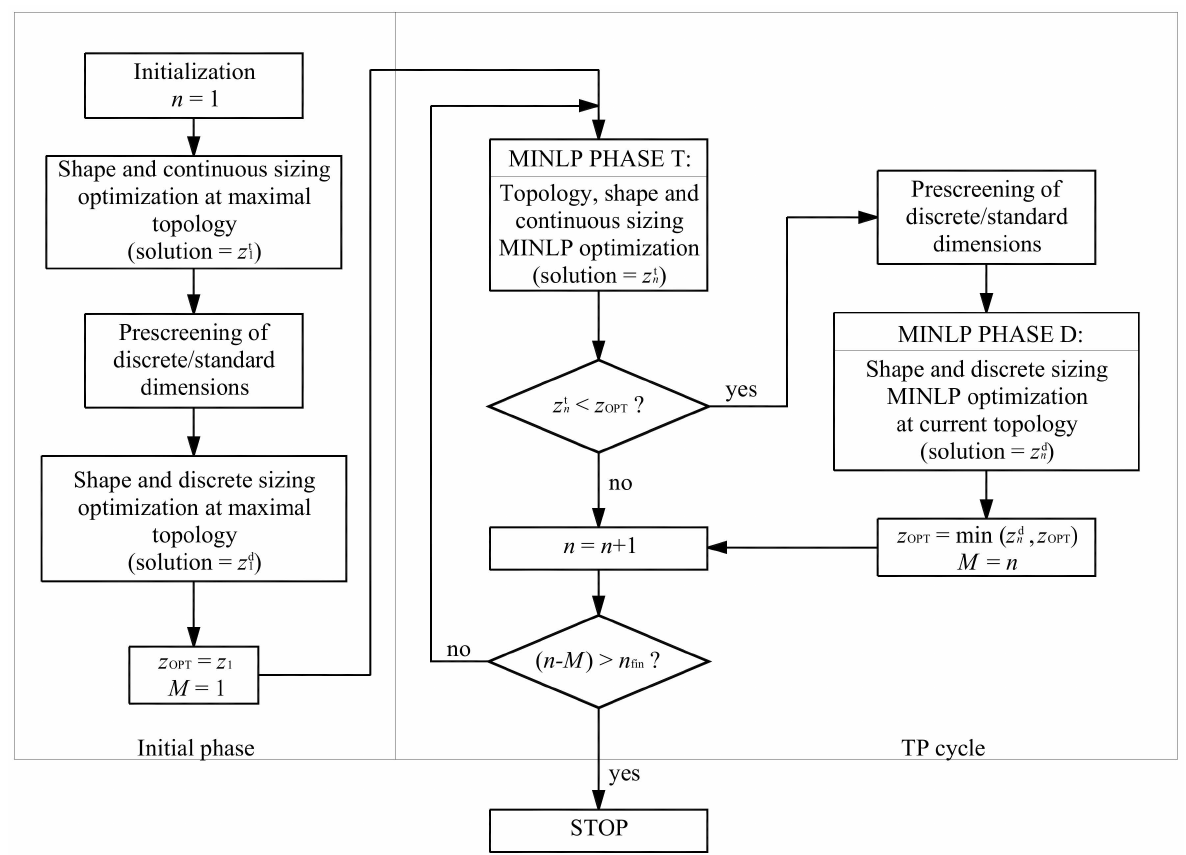
Figure 4. The Sequential Two-Phase MINLP